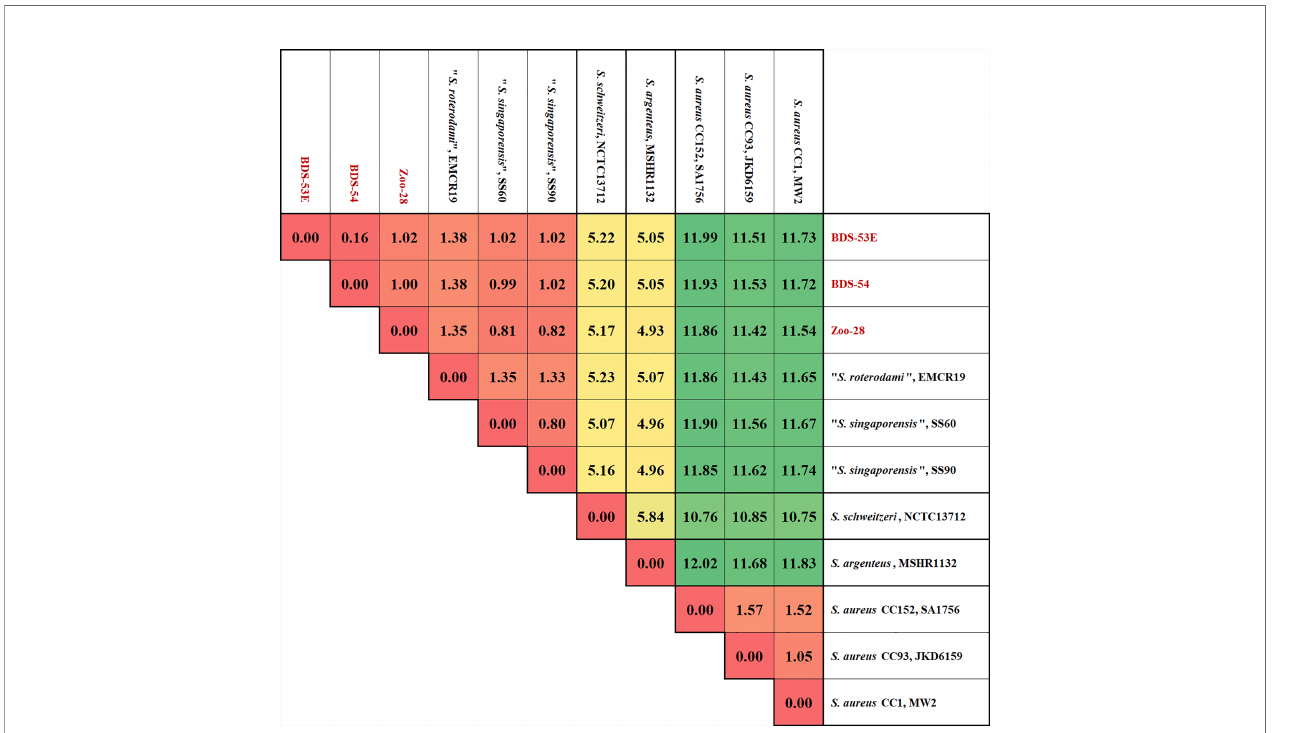
FIGURE 3 | Matrix of differences between BDS-53E, Zoo-28, “ S. roterodami ” (EMCR19, CAJGUT01), “ S. singaporensis ” (SS60 and SS90, NZ_JABWHF and NZ_JABWHD), S. schweitzeri , (NCTC13712, LR134304.1), S. argenteus (MSHR1132, FR821777.2) and three S. aureus lineages, CC1 (MW2, BA000033.2), CC93 (JKD6159, CP002114.2) and CC152 (SA17_S6, CP010941.1). The percentages were calculated as explained for Figure 2 and the image shows the median values over all these 2292 genes for each genome sequence compered to all others.